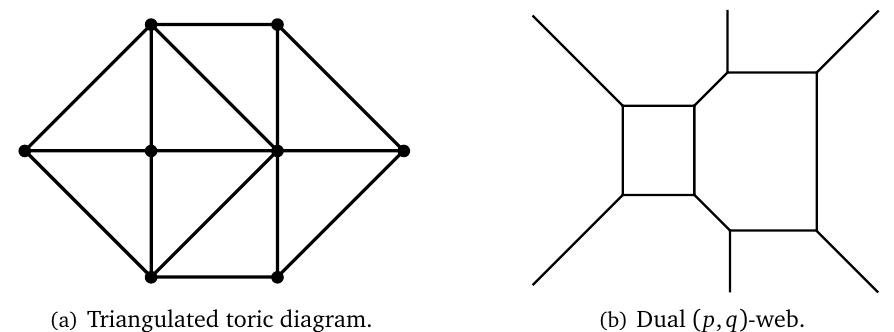
Figure 2: Triangulated toric diagram and dual ( p , q ) web for a particular resolution of the “beetle” singularity. This resolution admits both an SU ( 3 ) N SU ( 2 ) × SU ( 2 ) quiver gauge-theory